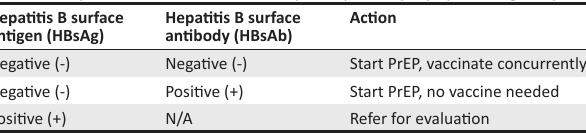
TABLE 3: Hepatitis B immune status and pre-exposure prophylaxis eligibility. Hepatitis B surface antigen